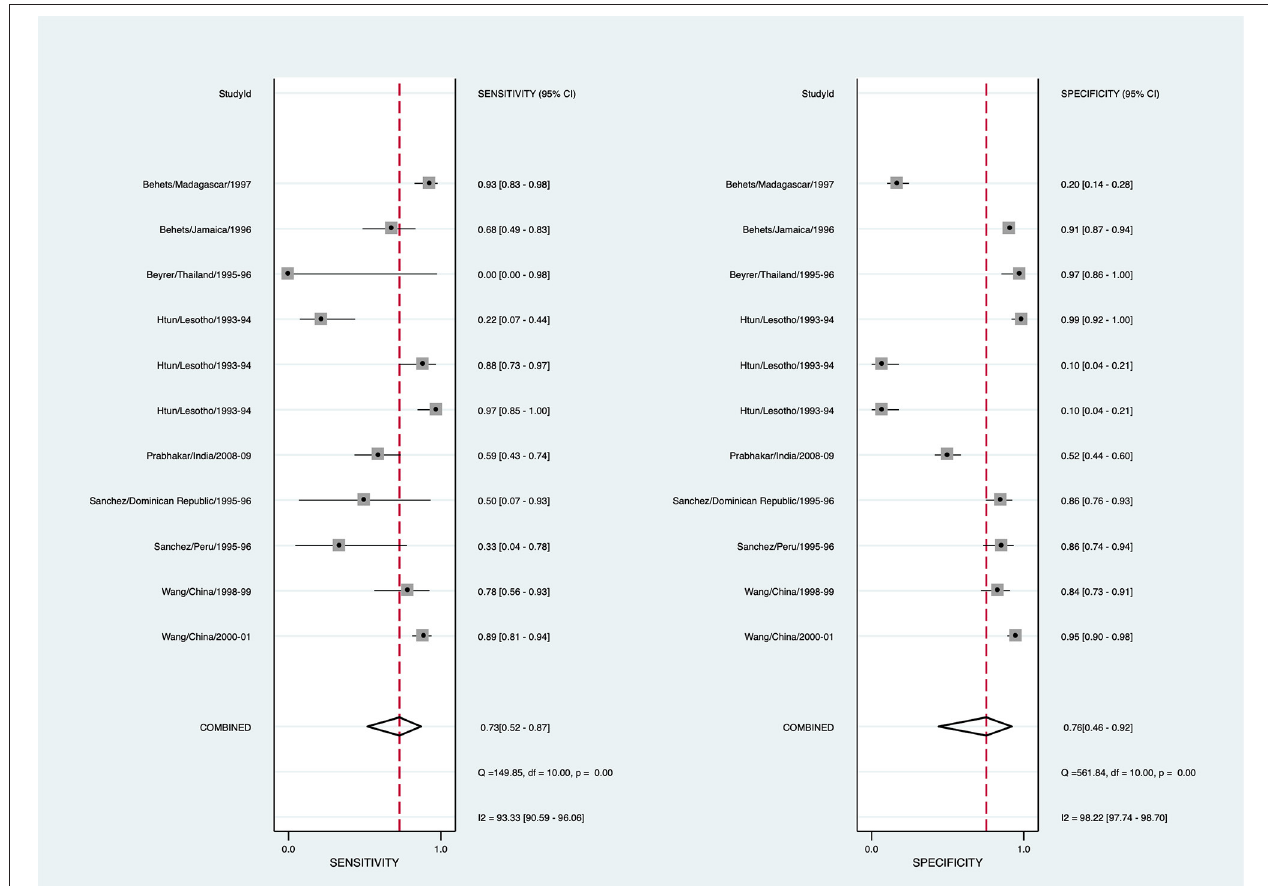
FIGURE 3 | Forest plot of the sensitivity and specificity of clinical diagnosis to detect syphilis in genital ulcer disease.